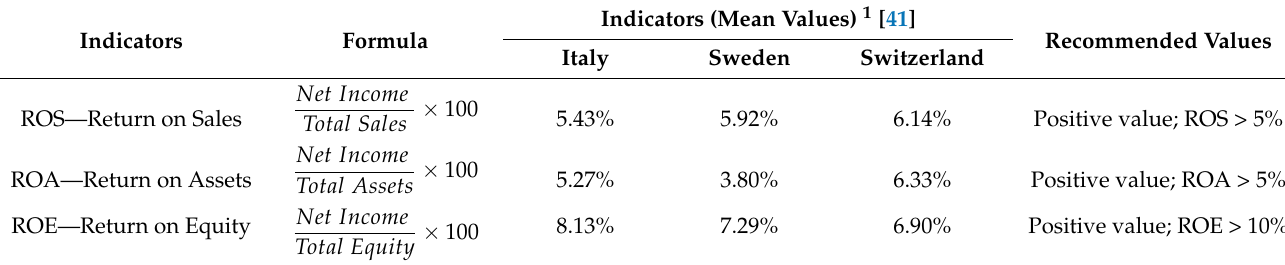
Table 3. Financial performance